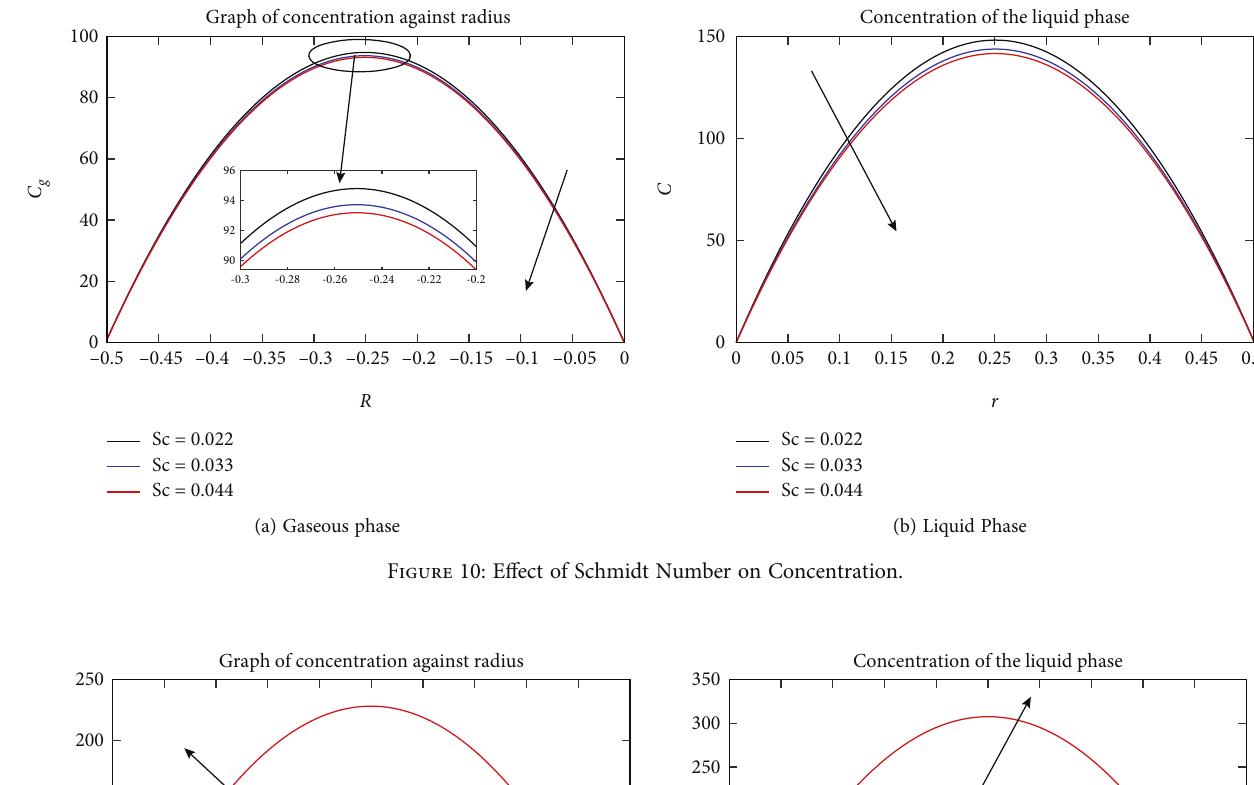
Figure 10: E ff ect of Schmidt Number on Concentration.